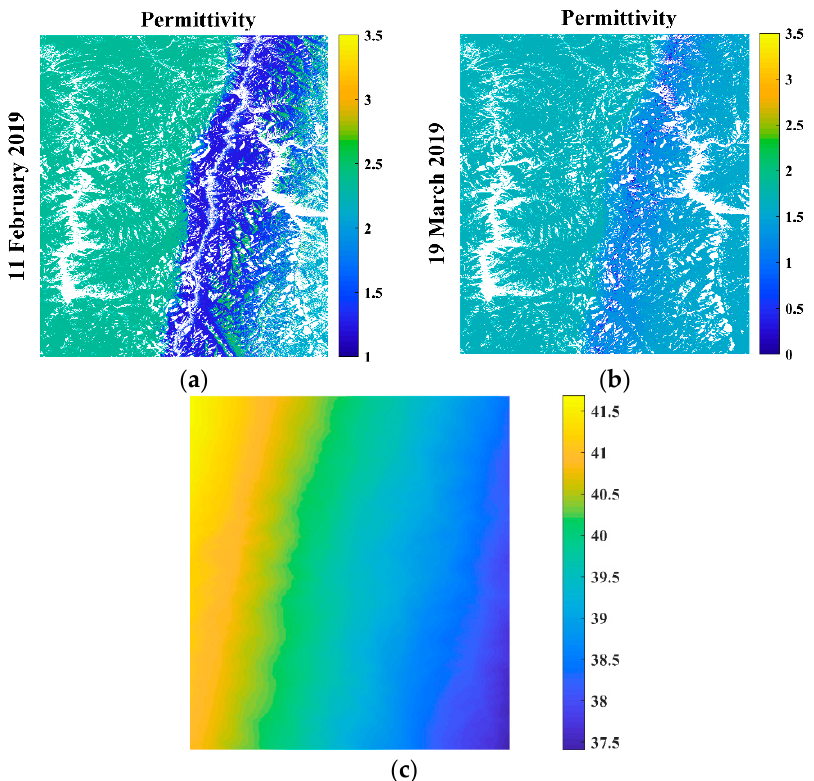
Figure 9. Estimated distribution maps of snow permittivity ( a , b ) and incidence angle ( c ) derived using proposed mythology for 11 February, and 19 March, 2019, Sentinel-1 dataset.